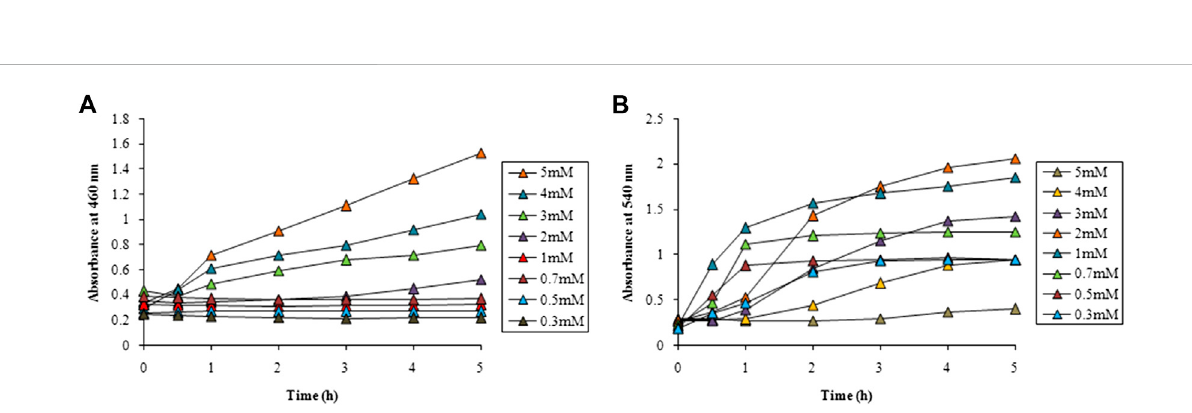
FIGURE 2 TimecourseofnanoparticlesynthesisusingLFLEat40 ° Cwith (A) differentconcentrationsofAgNO 3 and (B) HAuCl 4 .Thedifferenceinsynthesis is signi fi cant among different concentrations and time points with p < 0.05 by two factor